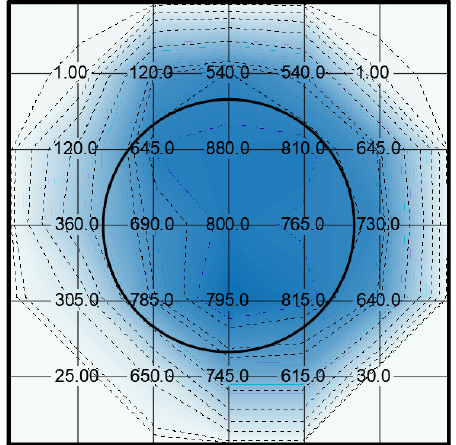
Figure 9. Example of spatial distribution of d 33 constant in a sample charged with an epoxy dielec- tric layer with an epoxy thickness of 400 μm. The numbers indicate the value of the d 33 constant in the measurement points and the circle the position of the high-voltage electrode.